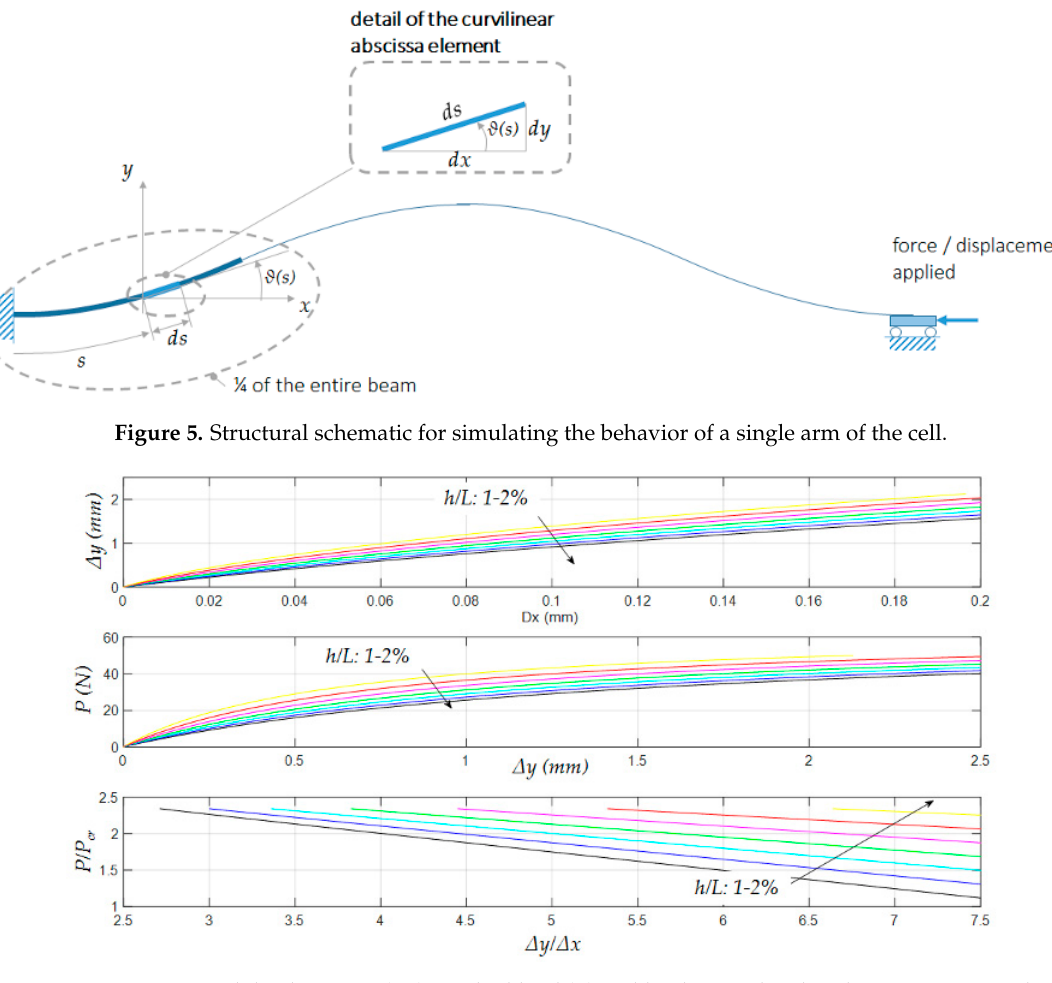
Table 1. Main features of the cell FE model. Length (mm)